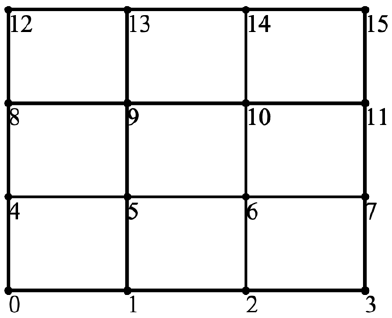
Figure 10. Most Efficient Graphs for 4 × 4 Lattice Converter from Node 0 to Node 15.